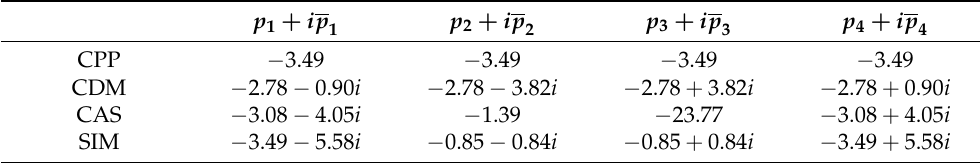
Table 4. Closed-loop poles for the considered controllers.